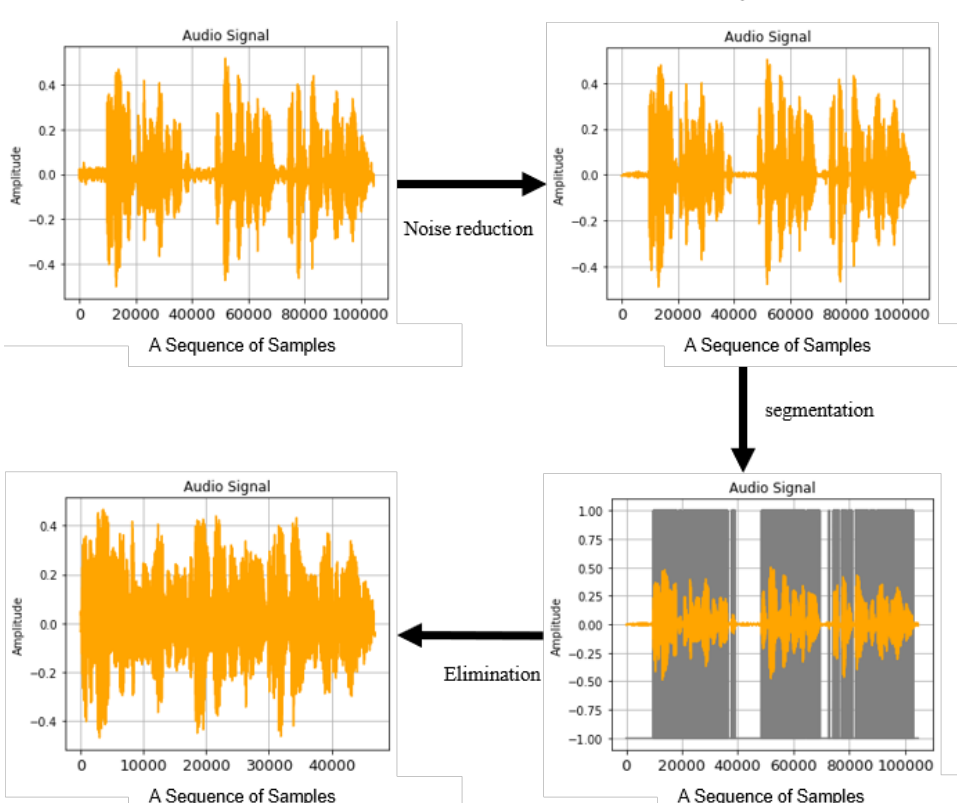
Figure 4. The overall process of the voice activity